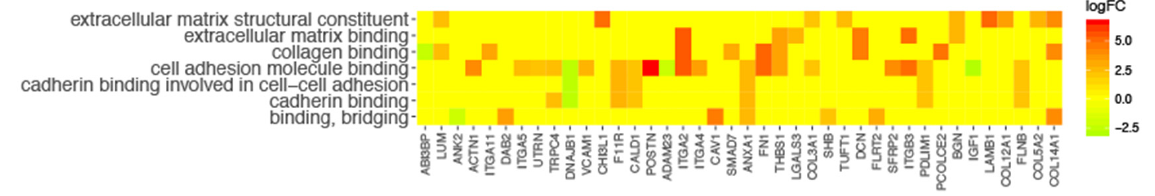
Figure 6. Heatmap presenting the relationship between genes and selected GO MF terms. Yellow color of tiles indicates the absence of logFC values.